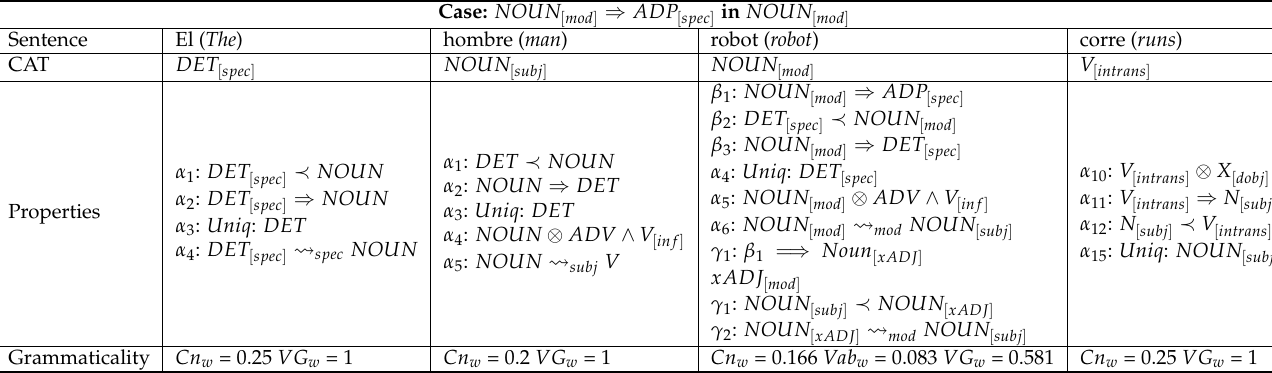
Table 11. NOUN in modifier construction as a xADJ